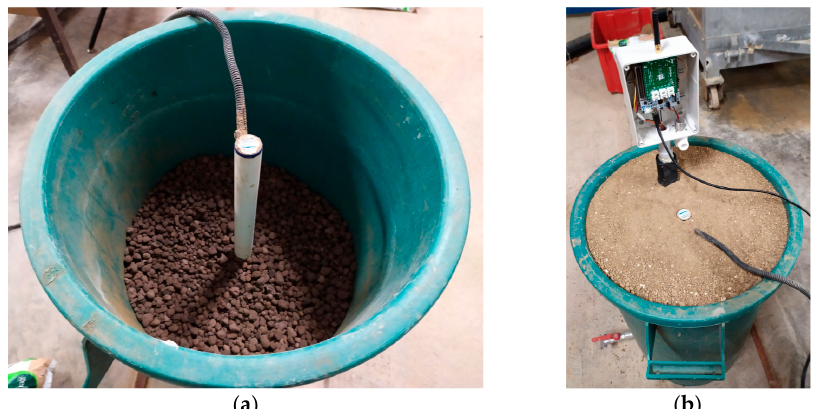
Figure 11. The plastic box used for our experiments. ( a ) Expanded clay aggregate bottom filler, to- gether with a Sentek Drill & Drop Probe. ( b ) Plant Node #1 and Sentek sensor during acquisition.